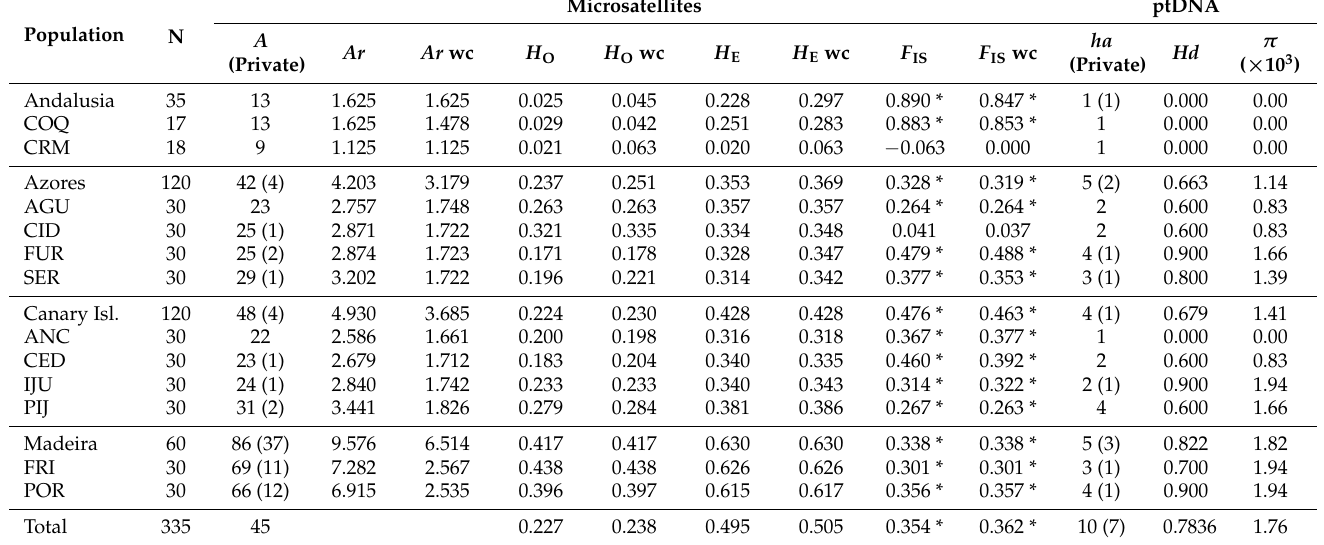
Table 3. Genetic diversity indices for microsatellites and ptDNA sequences in the populations of D. caudatum studied. Indices were calculated including all individuals sampled per population and including only one individual per MLLs per population (wc; without clones). N, number of individuals sampled; A , number of alleles with unique alleles in brackets; Ar , allelic richness at the smallest sample size (34 and 4 for populations with clones and without clones, respectively; 70 and 20 for geographical regions with clones and without clones, respectively) based on rarefaction; H O , observed heterozygosity; H E , expected heterozygosity [98]; F IS , inbreeding coefficient [99]; ha : number of haplotypes with unique haplotypes in brackets; Hd : haplotype diversity; π : nucleotide